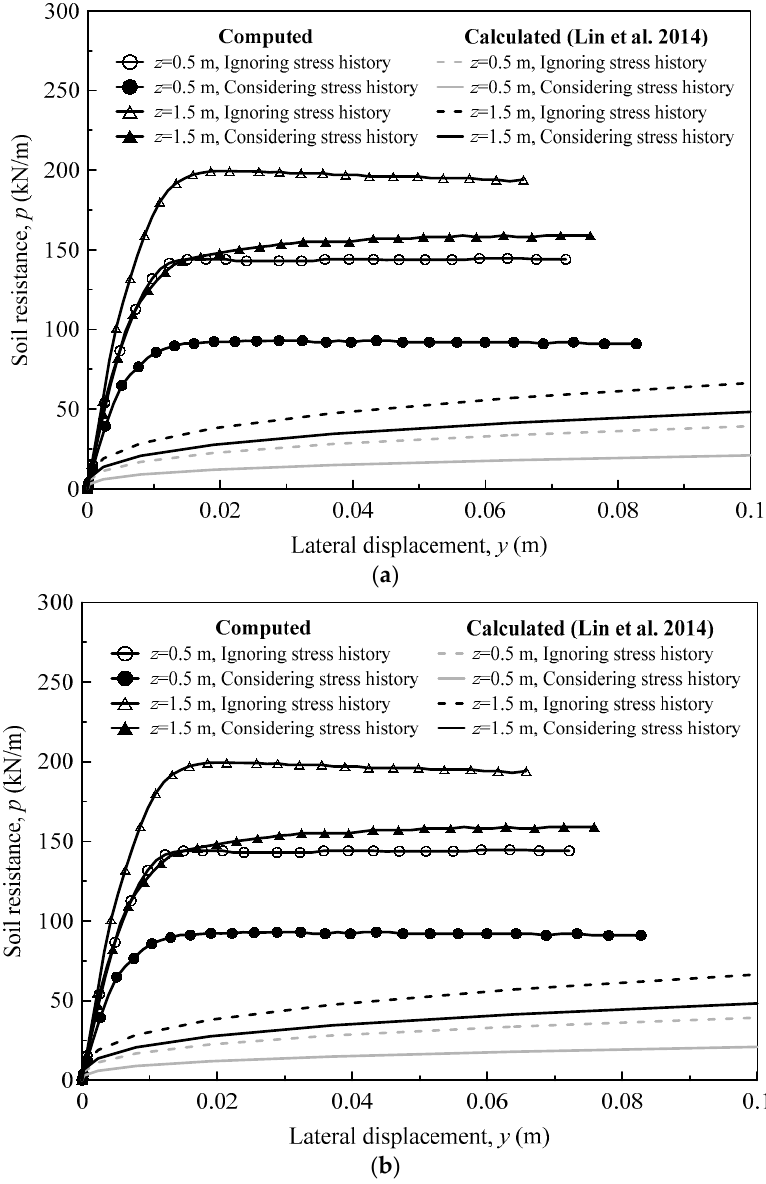
Figure 11. Comparison of the p-y curves at the scour depth of: ( a ) S d = 0.2 D ; ( b ) S d = 0.5 D . Note: The depth of the p-y curve, z , was measured from the post-scour mudline.